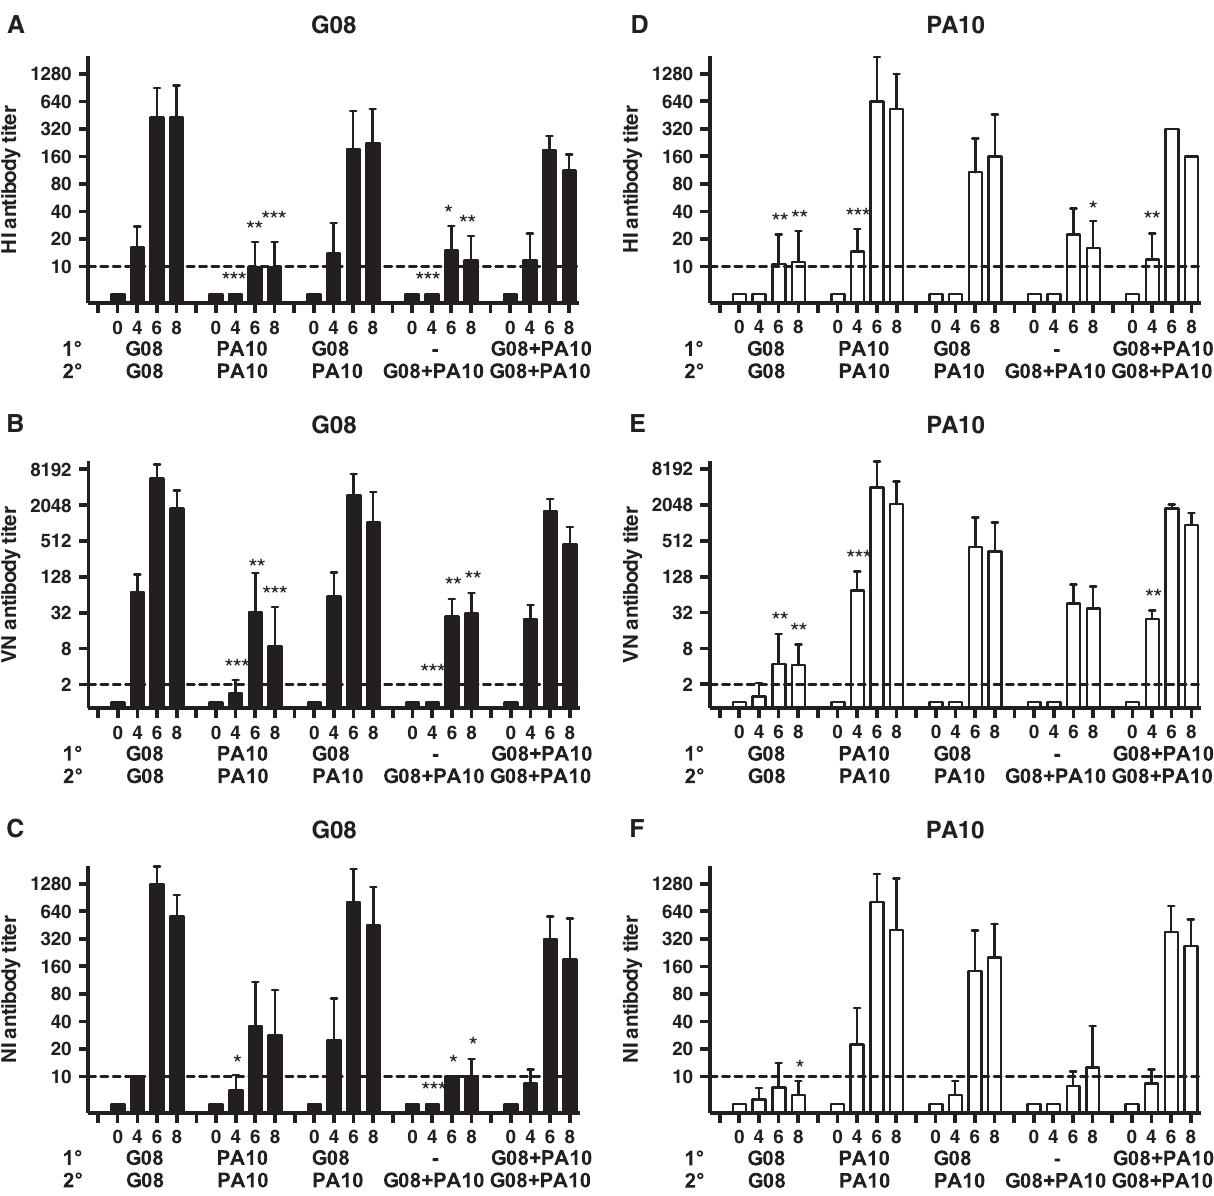
Fig. 1 Heterologous prime-boost vaccination with G08 and PA10 induces antibodies against both vaccine strains. Serum antibody titers are compared with those achieved by homologous prime-boost vaccination and one or two administrations of bivalent vaccine. The time interval between the priming (1°) and booster (2°) immunizations was 4 weeks. HI ( a , d ), VN ( b , e ) and NI ( c , f ) antibody titers were determined at 4 timepoints: before the priming vaccination, 4 weeks after the priming vaccination and before the booster vaccination, and 2 and 4 weeks after the booster vaccination (weeks 0, 4, 6, and 8). The vaccine groups are grouped along the x-axis. The bivalent vaccine (1x) group received a single vaccine administration at week 4 of the experiment. Geometric mean antibody titers against G08 and PA10 are shown in fi gures a – c and d – f respectively. Error bars represent SD. Dotted lines indicate limits of detection. Pigs of the mock-vaccinated control group (not shown) had no detectable antibody titers in all three assays. Asterisks denote signi fi cant differences between the heterologous prime-boost and other groups in the Kruskal-Wallis test. * P < 0.05; ** P < 0.01; *** P <